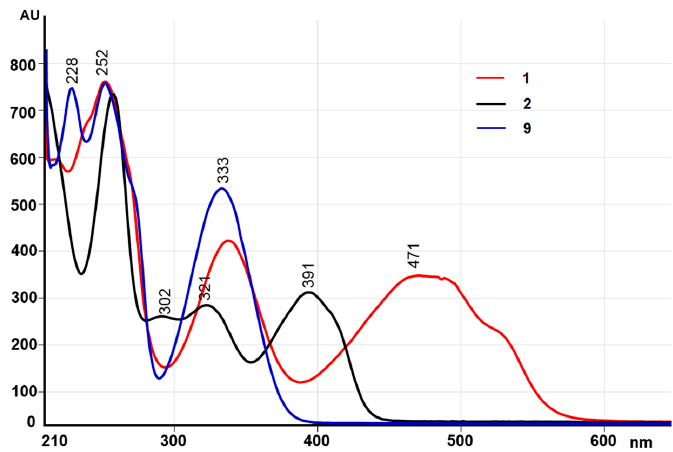
Figure 5. Absorption spectra of Ech A ( 1 ) and its oxidation products 2 and 9 . Table 2. HPLC coupled with diode array detection (DAD) and MS parameters of Ech A ( 1 ) and its oxidation products 2 and 7 – 10 .